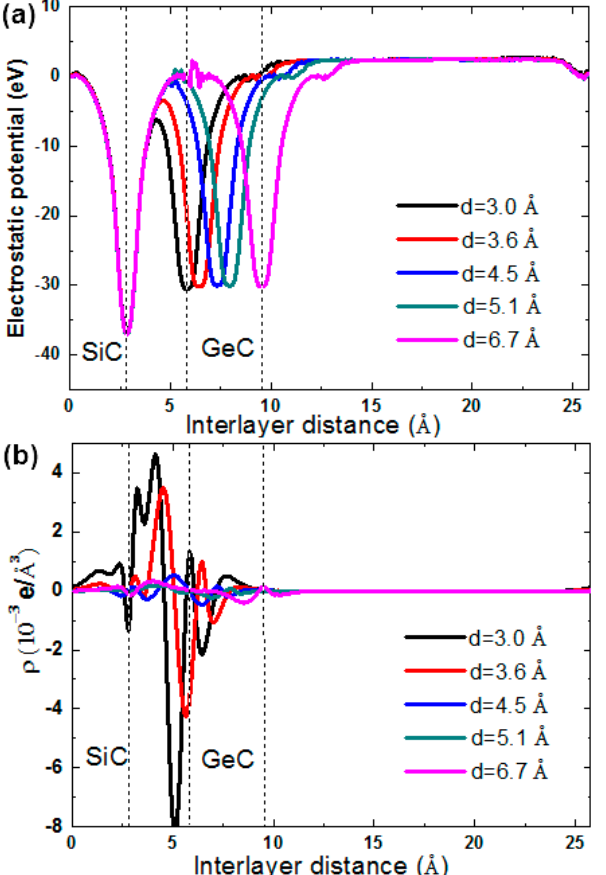
Figure 4. (Color online) ( a ) Electrostatic potentials and ( b ) plane-averaged charge density differences of the SiC/GeC vdW heterostructures with different interlayer distances.